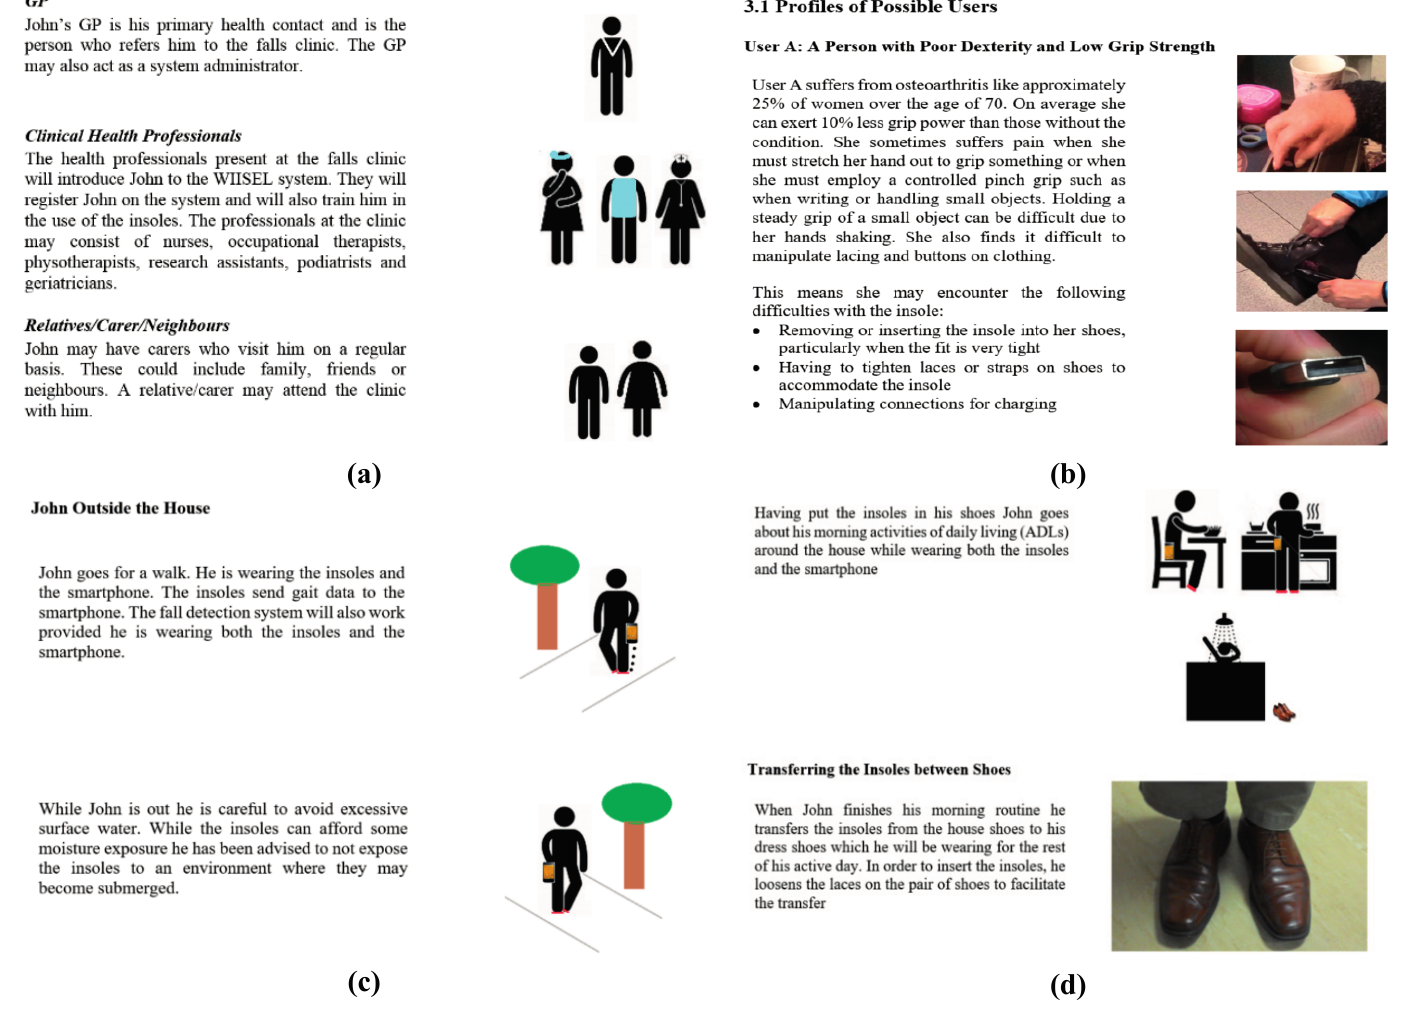
Figure 3. Screenshots of the WIISEL insole use case describing: ( a ) the different actors who would be interacting with the system; ( b ) the possible physical limitations of the target users; ( c ) how the user might interact with the insole in an outdoor setting; and ( d ) how the user might interact with the insole throughout the